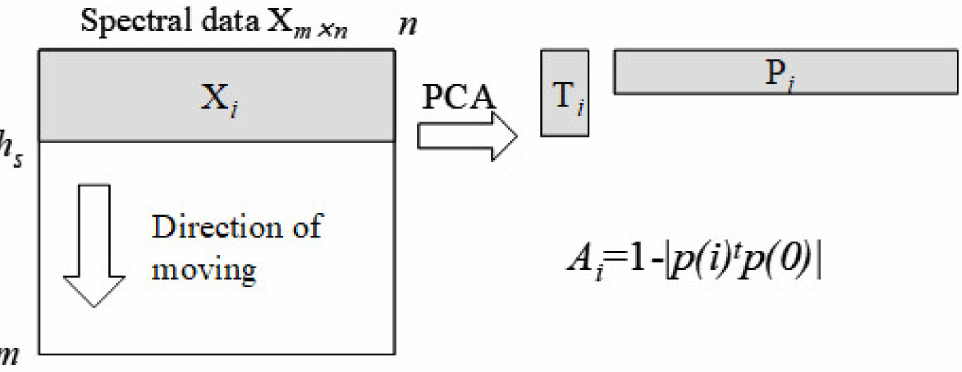
Figure 1. Schematic picture of the algorithm of moving window principal component analysis (MWPCA): X i is i th submatrix of spectral data X m × n, and h s is the time-window size of X i . P i and T i indicate the principal components and scores of X i, respectively. A i is a dissimilarity index to detect a change between angles of the first principal component in P i , p ( i ), and its reference, p